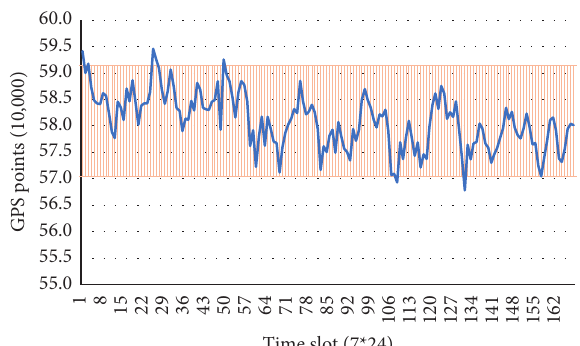
Figure 1: Fluctuation trend of the number of GPS positioning points per hour for 7 days. Note: the vertical line in the figure is the error line with 2 times the standard